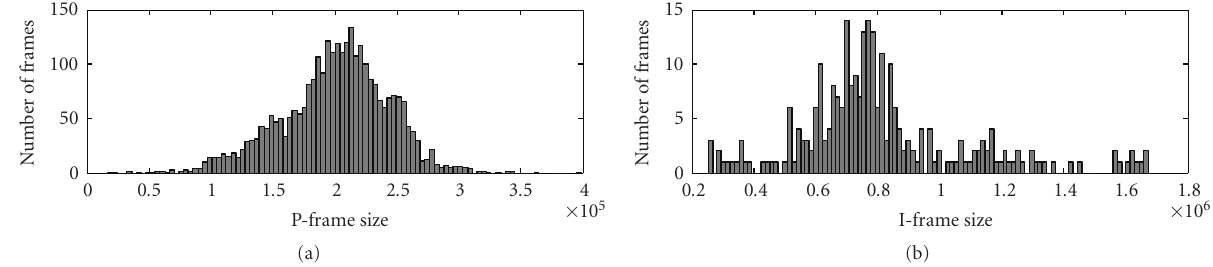
Figure 9: Histograms of P and I frame size in “The Living Sea” video sequence encoded by FFMPEG VBR video rate controller.